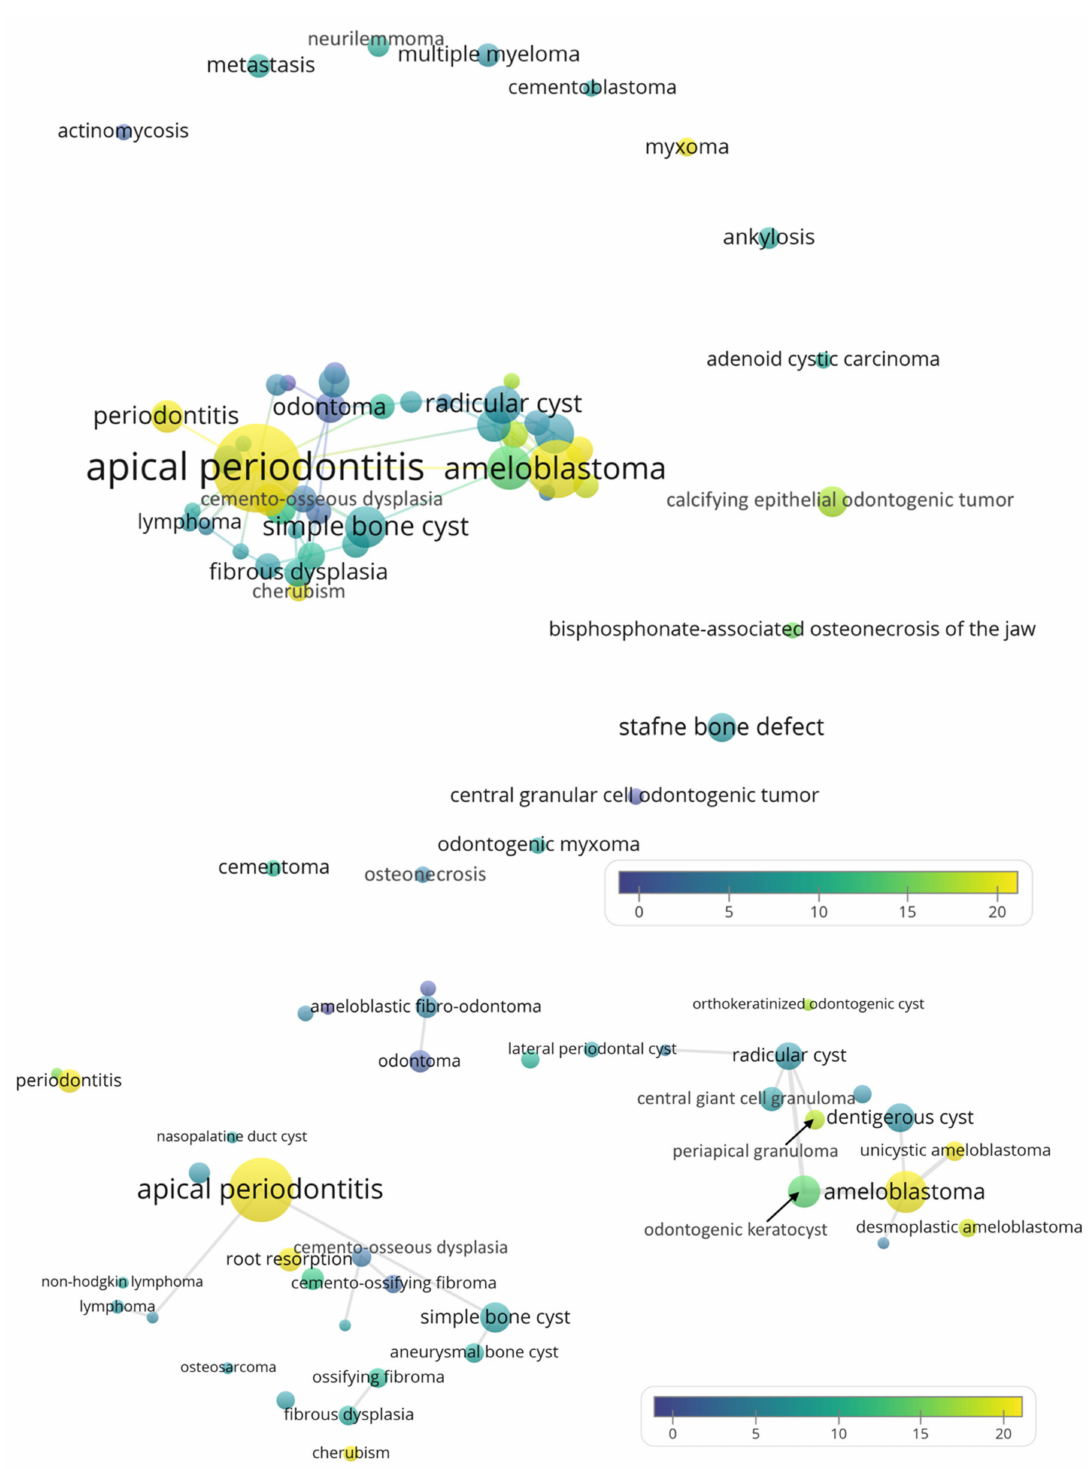
Figure 2. Recurring radiolucent lesions mentioned in the author keywords of the analyzed papers. Upper panel: the overall term map. Lower panel: zoomed-in view that focuses on the center of the map (the lines only connect lesions that co-occurred at least 2